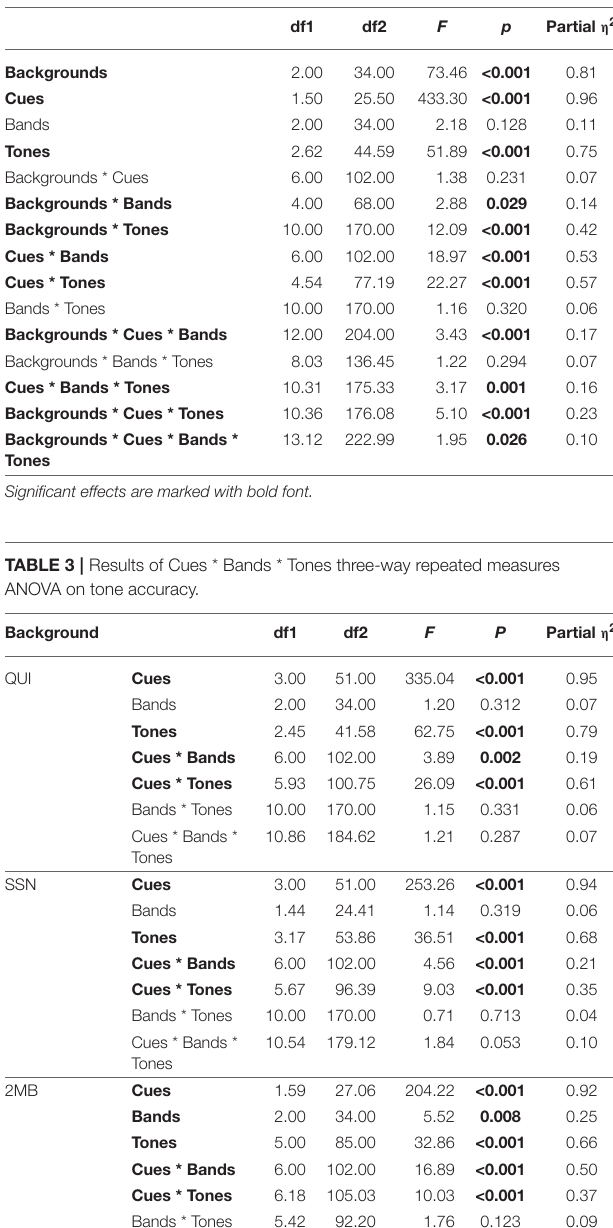
ANOVA was conducted for each type of Background ( Table 3 ).